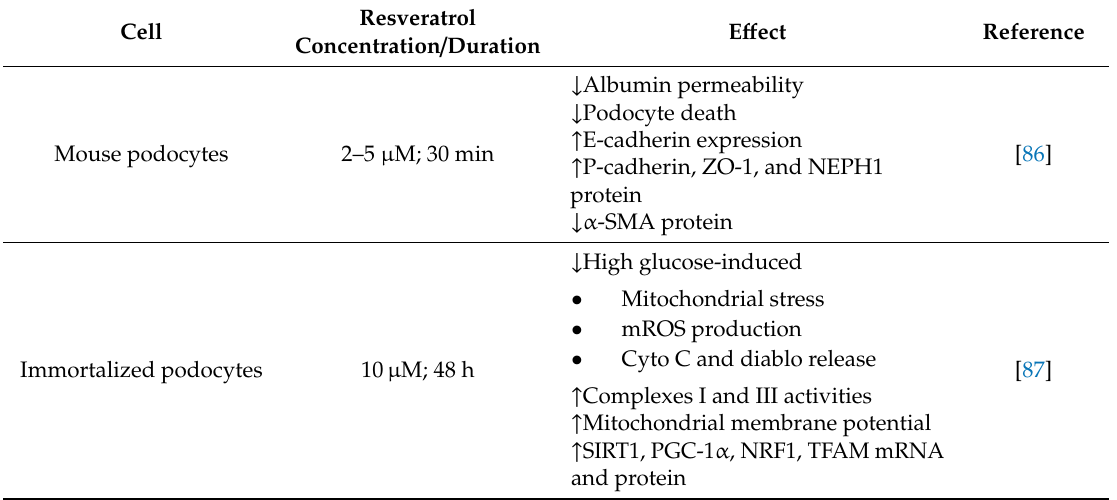
Table 3. E ff ects of resveratrol on cells of the renal